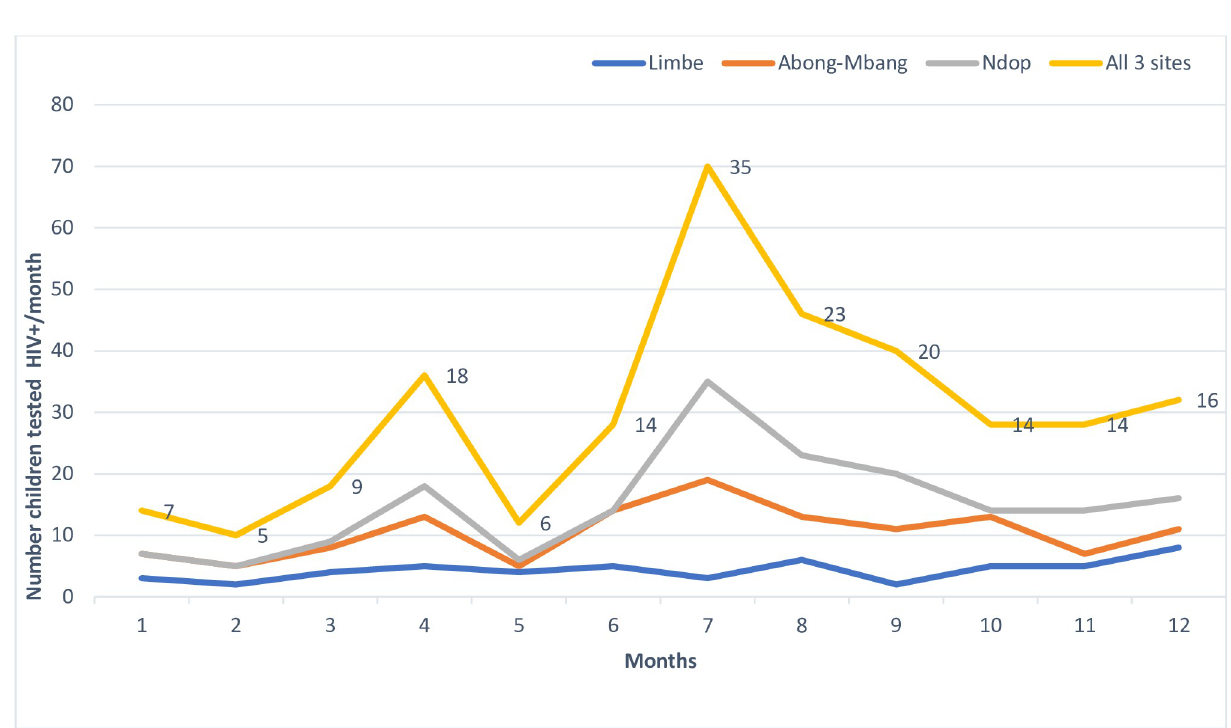
Fig 2. Trends in the number of children/adolescents tested HIV+ before and after the intervention.